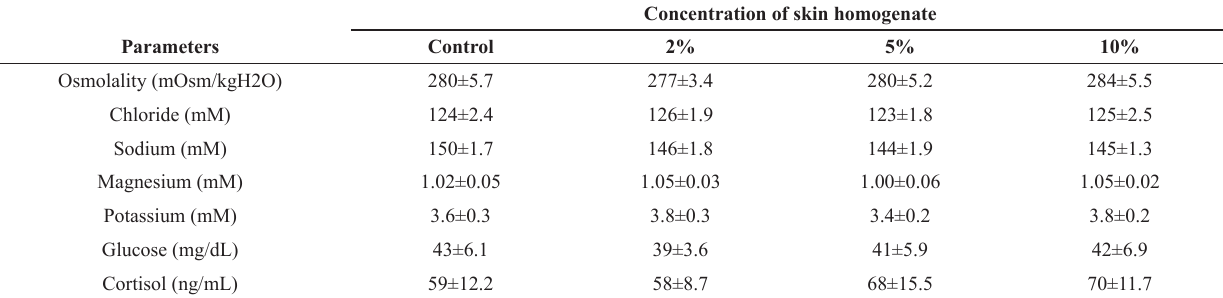
Table 1. Plasma parameters evaluated in Rhamdia quelen exposed to different concentrations of the skin homogenate containing the alarm substance from conspecifics. Data displayed as mean ± s.e.m., n= 9-10. There were no differences between any of the values of the experimental groups and the values of the control